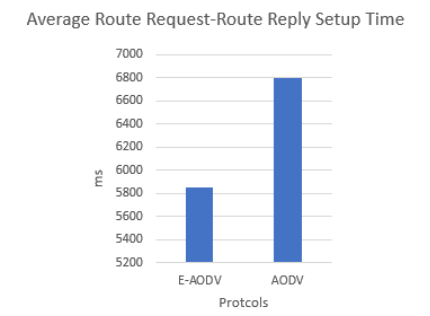
Figure 23. Average RREQ-RREP setup